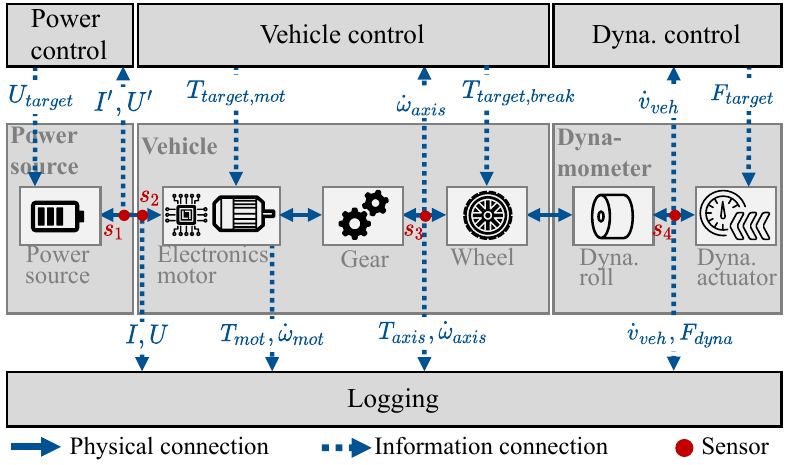
Figure 6. Schematic test control and measurement setup of the prototype electric vehicle NEmo on a roller